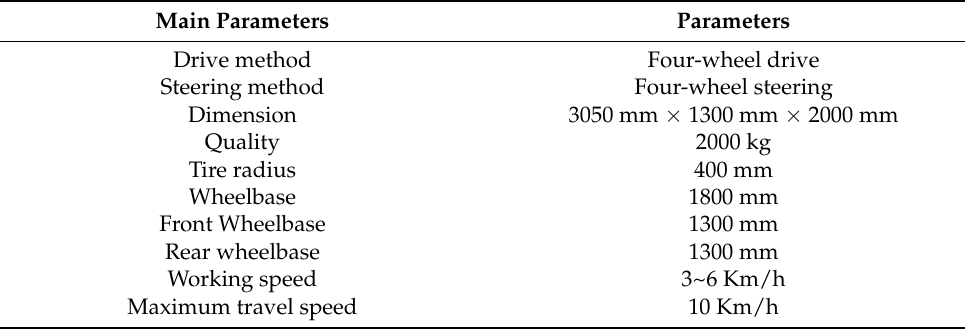
Table 2. Important parameters of 4WS agricultural machinery.